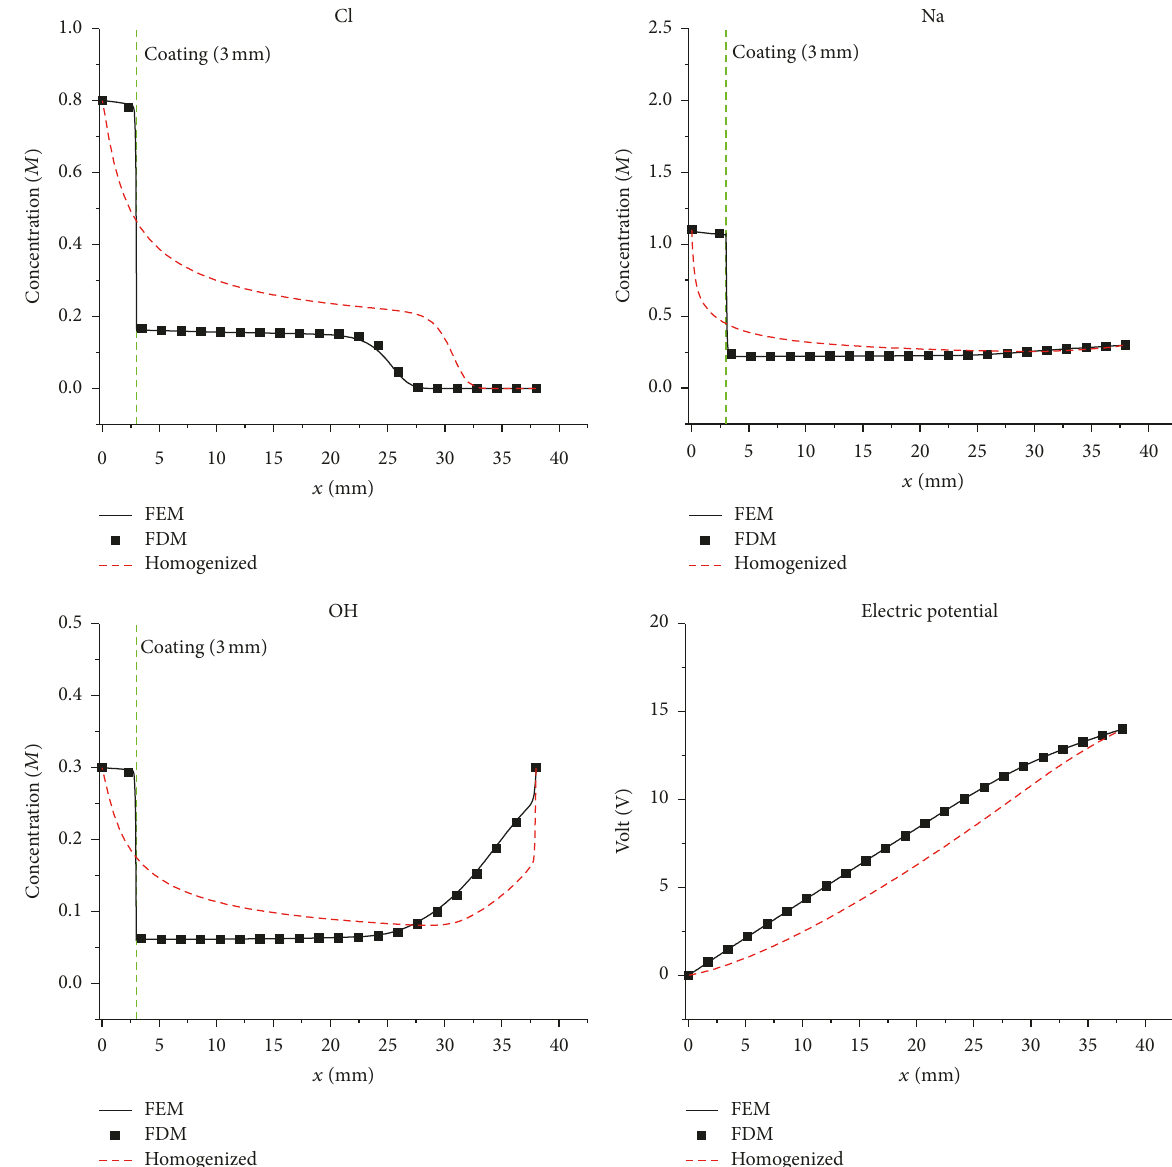
Figure 6: Ionic and electric potential profiles after 24-hour migration test ( 𝐷